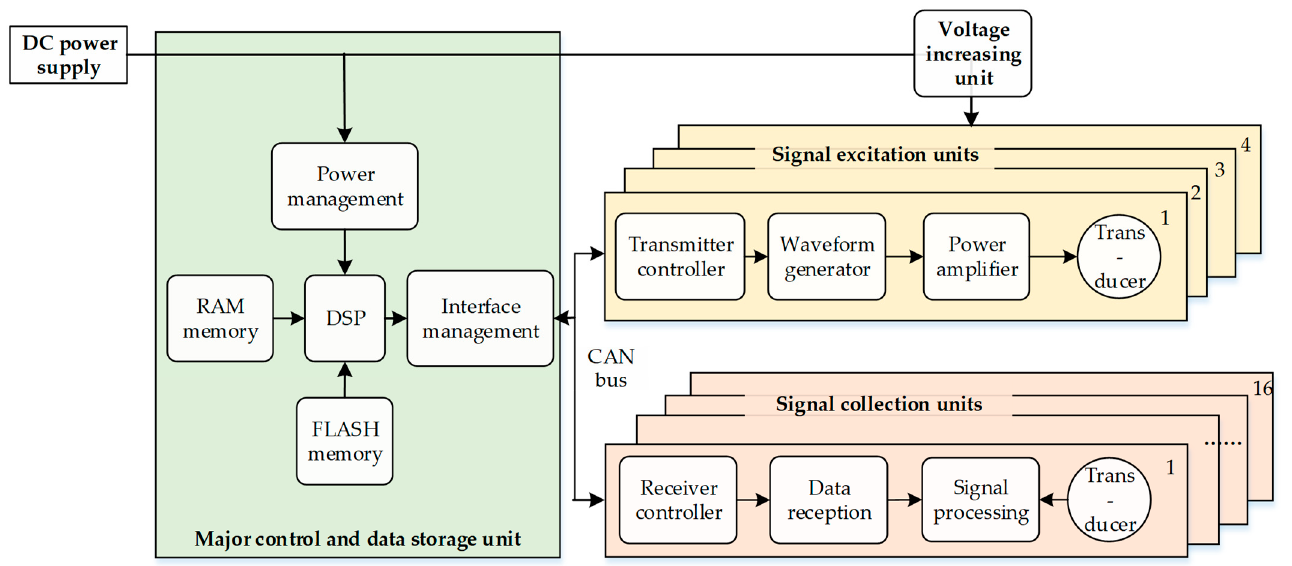
Figure 2. Structural diagram of the electronic system in the designed LWD